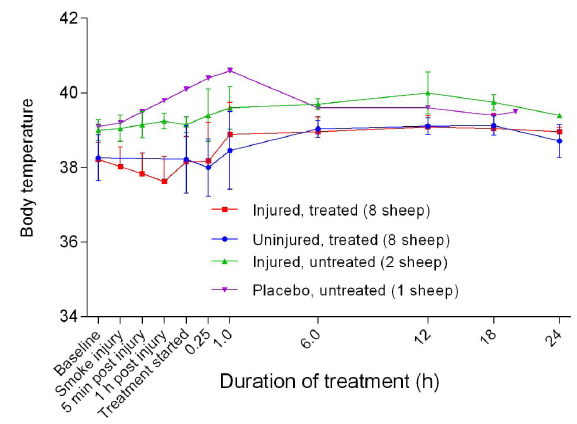
Figure 49. Body temperature (Mean ± SD) of smoke and non- smoke injured sheep that received extracorporeal life support as compared to that of untreated